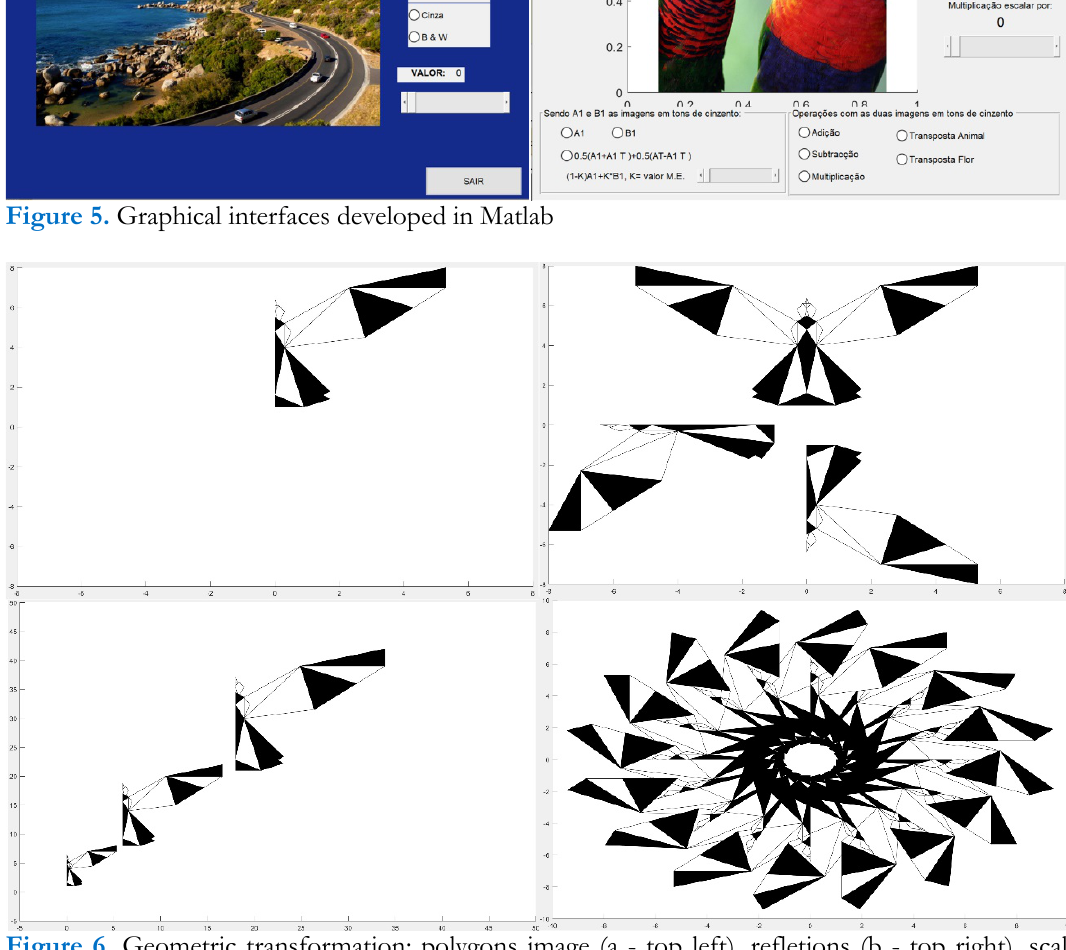
Figure 6. Geometric transformation: polygons image (a - top left), refletions (b - top right), scale change (c - bottom left) and rotation (d - bottom